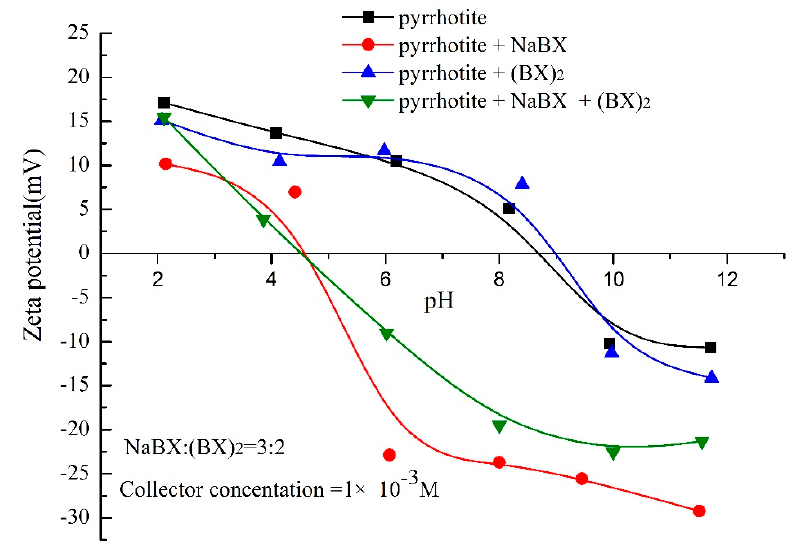
Figure 7. The zeta potential of pyrrhotite in the absence and presence of NaBX, (BX) 2 , and their mixture as a function of pH value, respectively.